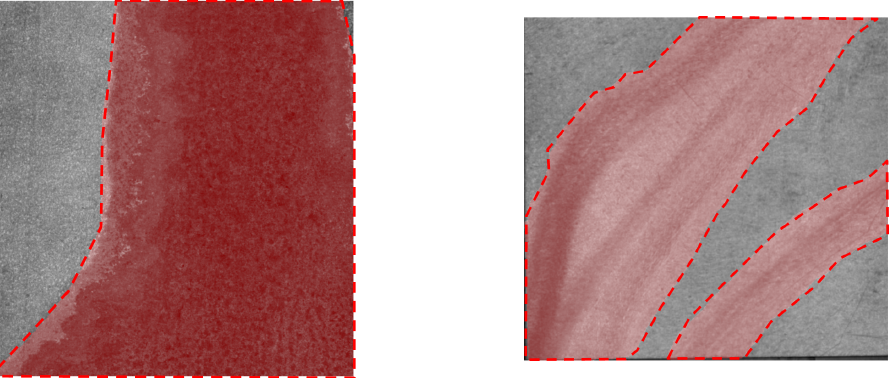
Figure 4. Texture channel of RGB photometric-stereo images with corresponding ground truth masks in red and dotted lines.